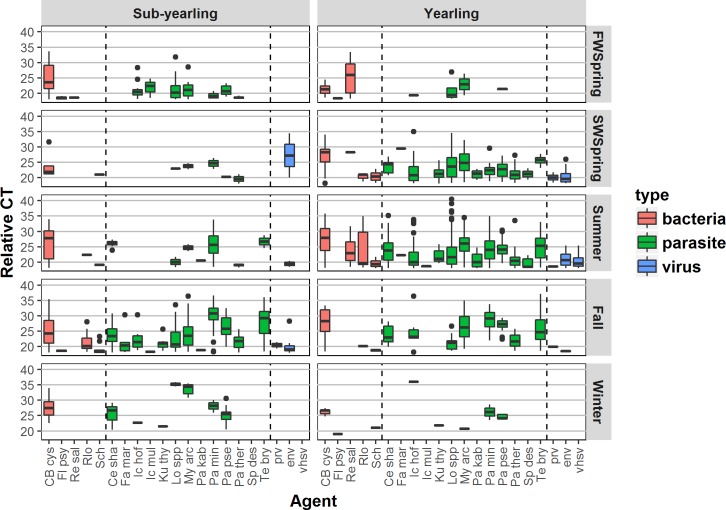
Boxplot of seasonal load (relative CT) of infectious agents in sub-yearling and yearling juvenile Chinook salmon from the Fraser River.Sample sizes are provided in Table 1; full names are provided in S1 Table. Infectious agents are separated into type (bacteria, parasite and virus).